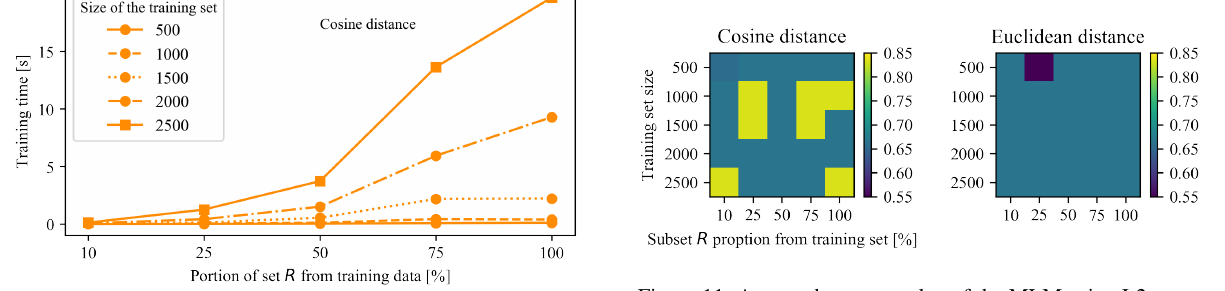
Figure 7. Training time of the MLM using cosine distance varying size of the training set and proportion subset R .